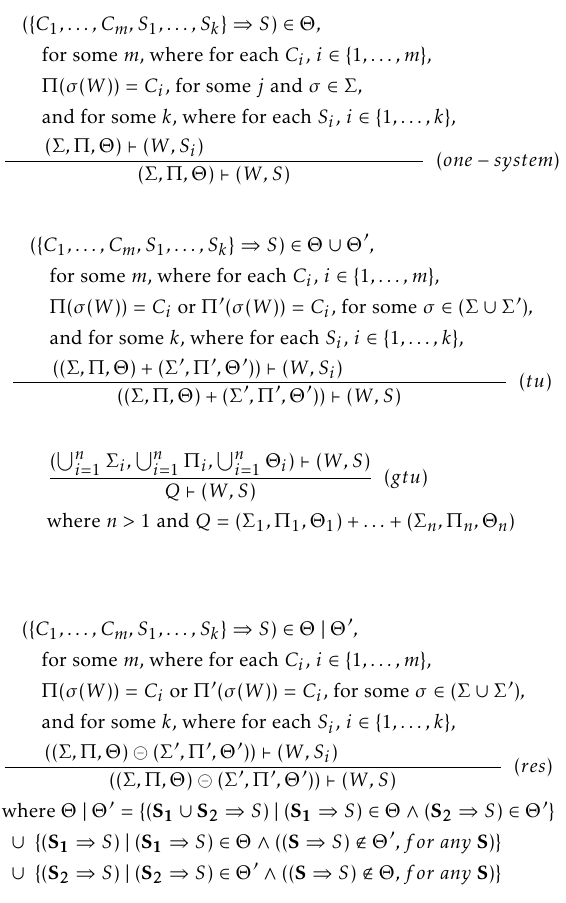
Figure 1. Overview of Sigma operators and associated rules - part 1.